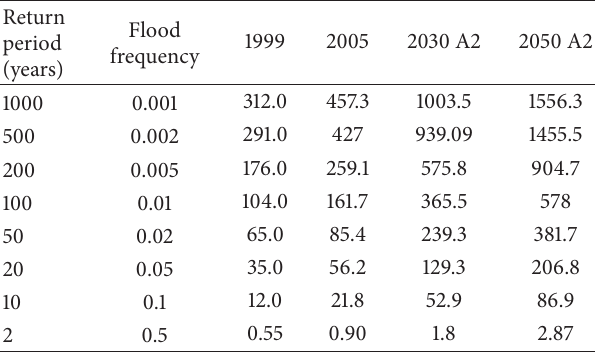
Table 1: Predicted results of GDP and population.